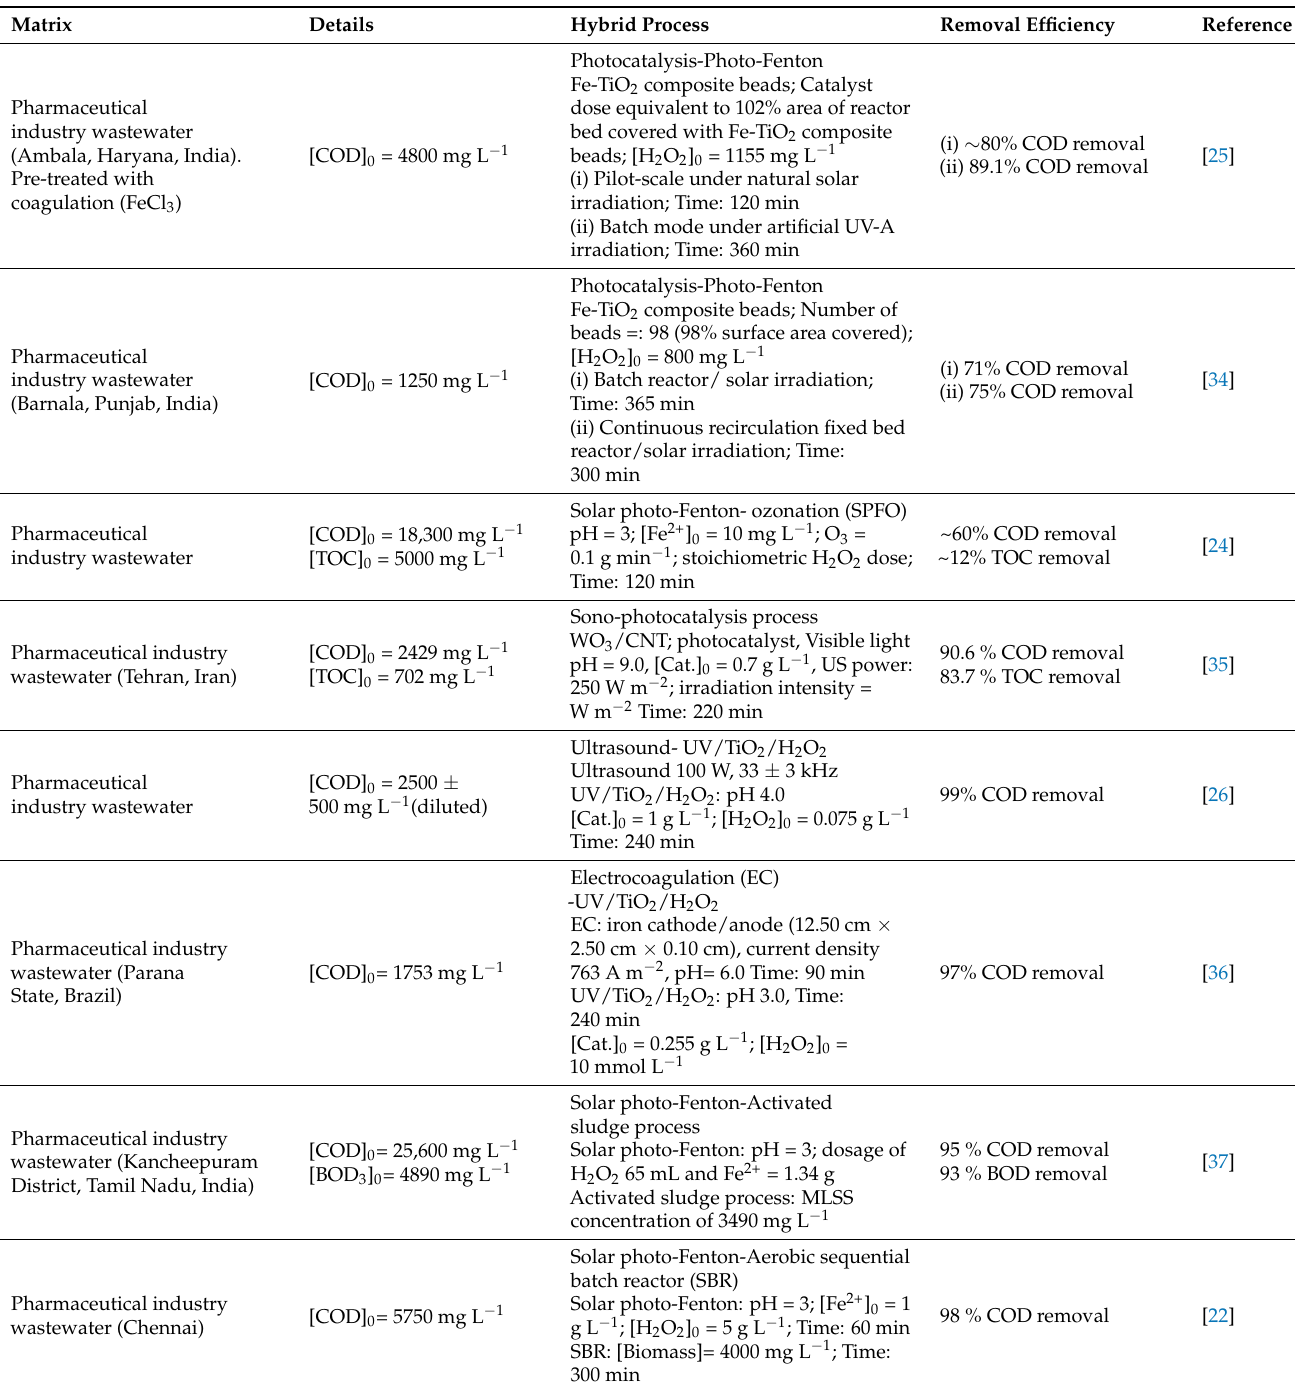
Table 5. Hybrid systems (coupling of homogeneous/heterogeneous photocatalysis with other pro- cesses) for the treatment of pharmaceutical industry